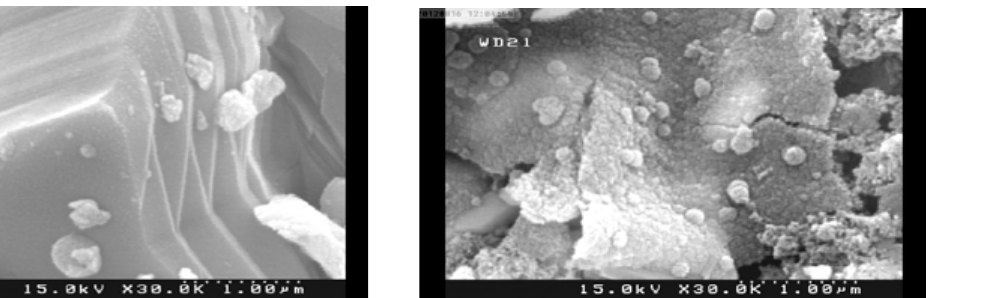
Fig. 2. XRD patterns: (c) simulated pattern based on single crystal data of compound 2, (d) nano-particles of compound 2